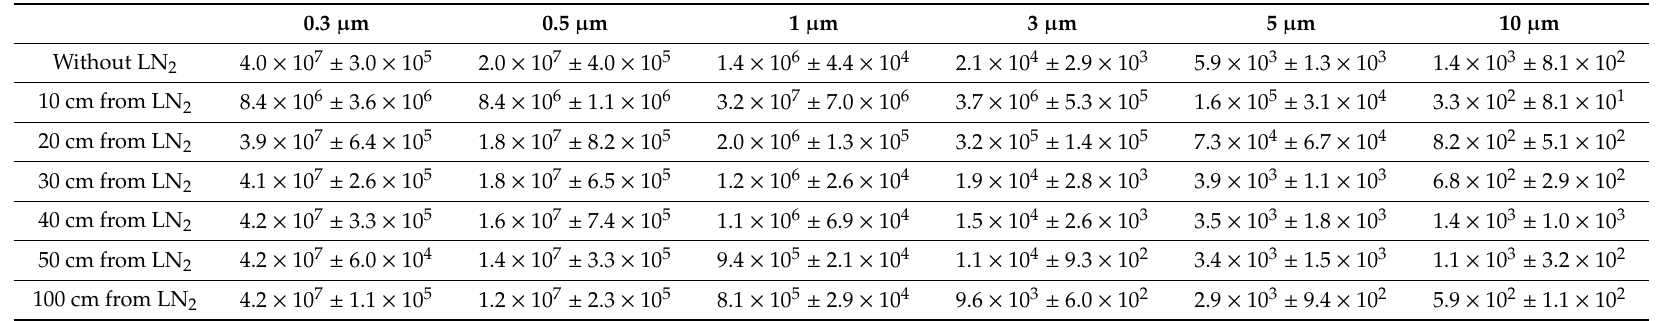
Table 2. Aerosol particle concentrations (particles / m 3 ) in the vicinity of liquid nitrogen (LN 2